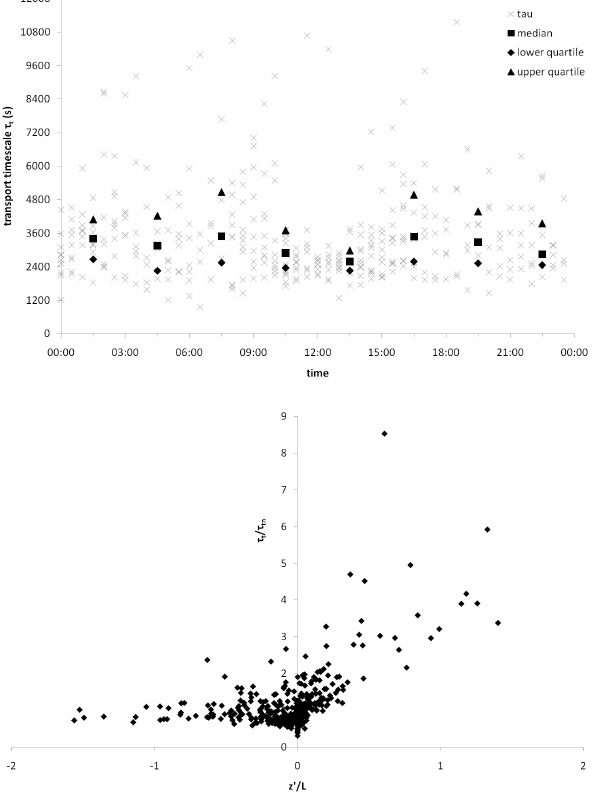
Figure 7. Transport timescale τ t calculated for REPARTEE II. b) τ t normalised by near neutral Fig. 7. Transport timescale τ t calculated for REPARTEE II. (a) di- value (z‟/L < 0.1) as a function of Monin-Obukhov stability parameter z‟/L. urnal cycle throughout campaign. Median, upper and lower quartile values calculated over 3h periods also shown. (b) τ t normalised by near neutral value ( | z’/L | < 0.1) as a function of Monin-Obukhov stability parameter